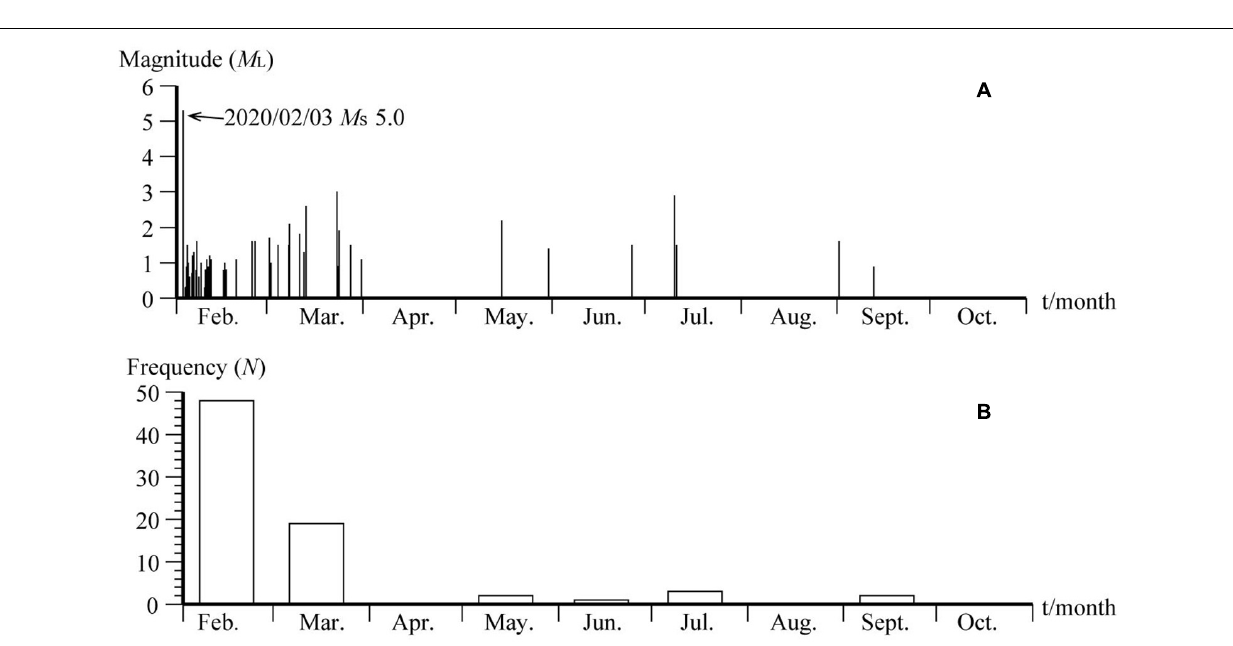
Frontiers in Earth Science |